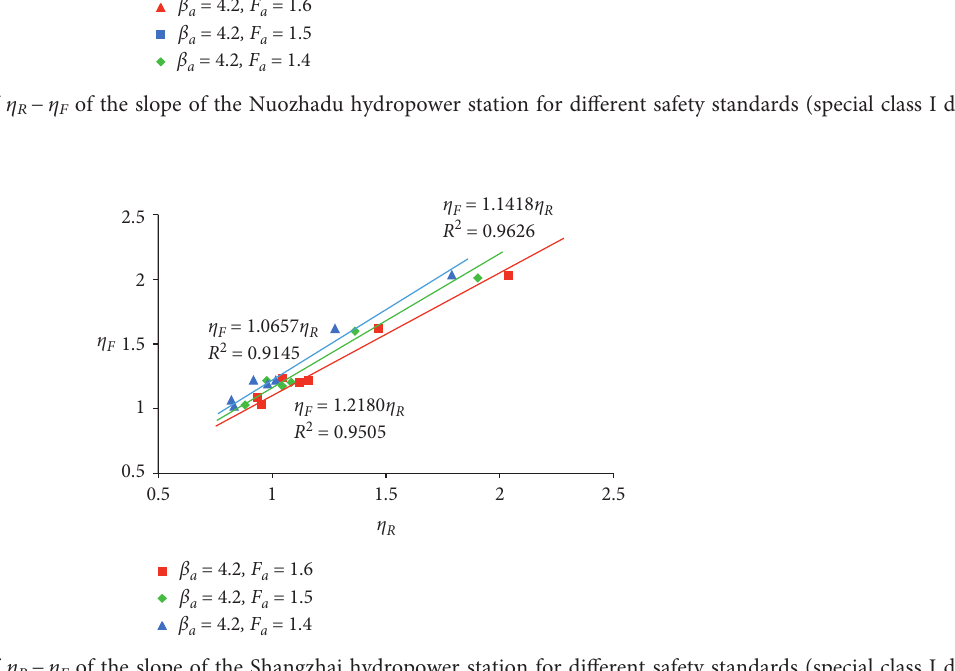
F of the slope of the Shangzhai hydropower station for different safety standards (special class I dam